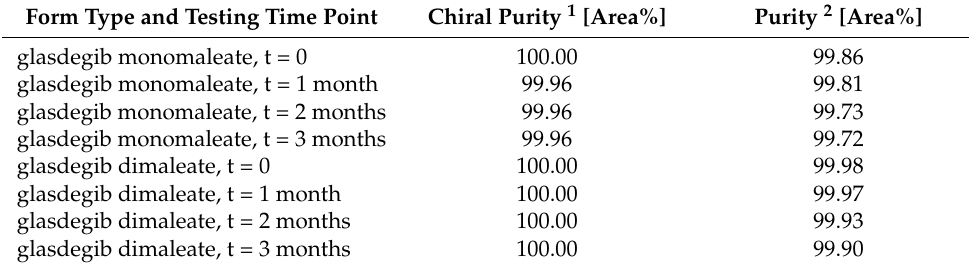
Table 3. Stability of glasdegib monomaleate and glasdegib dimaleate.